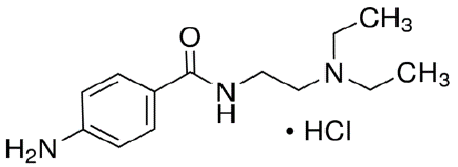
Figure 1: Chemical structure of procainamide